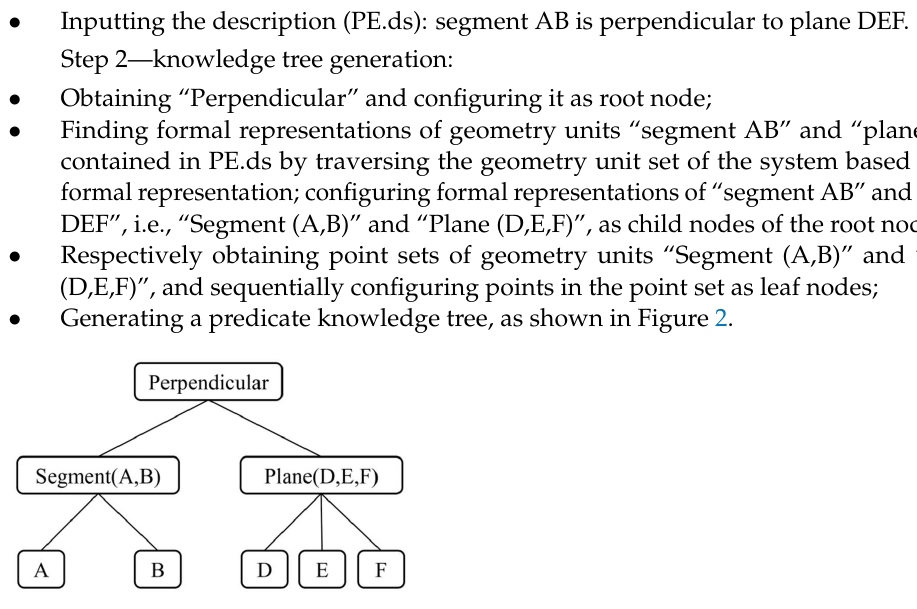
Figure 2. Predicate knowledge tree.